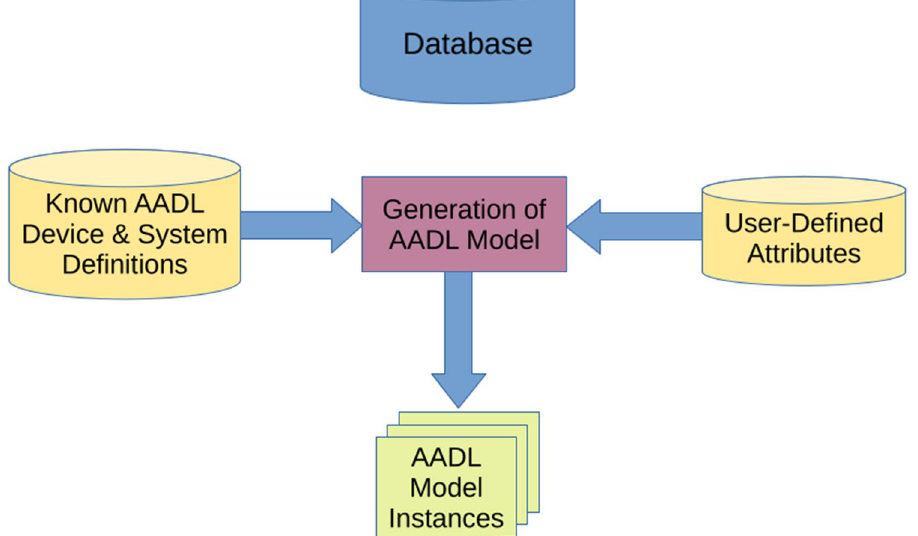
Fig. 3 Illustration of flow graph for